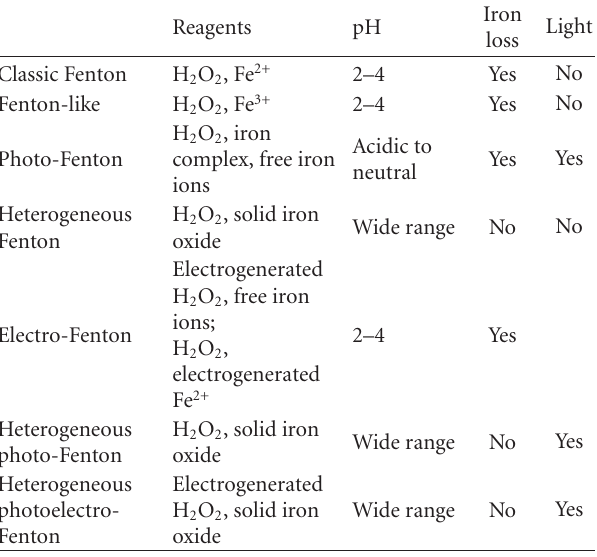
Table 1: Varieties of Fenton